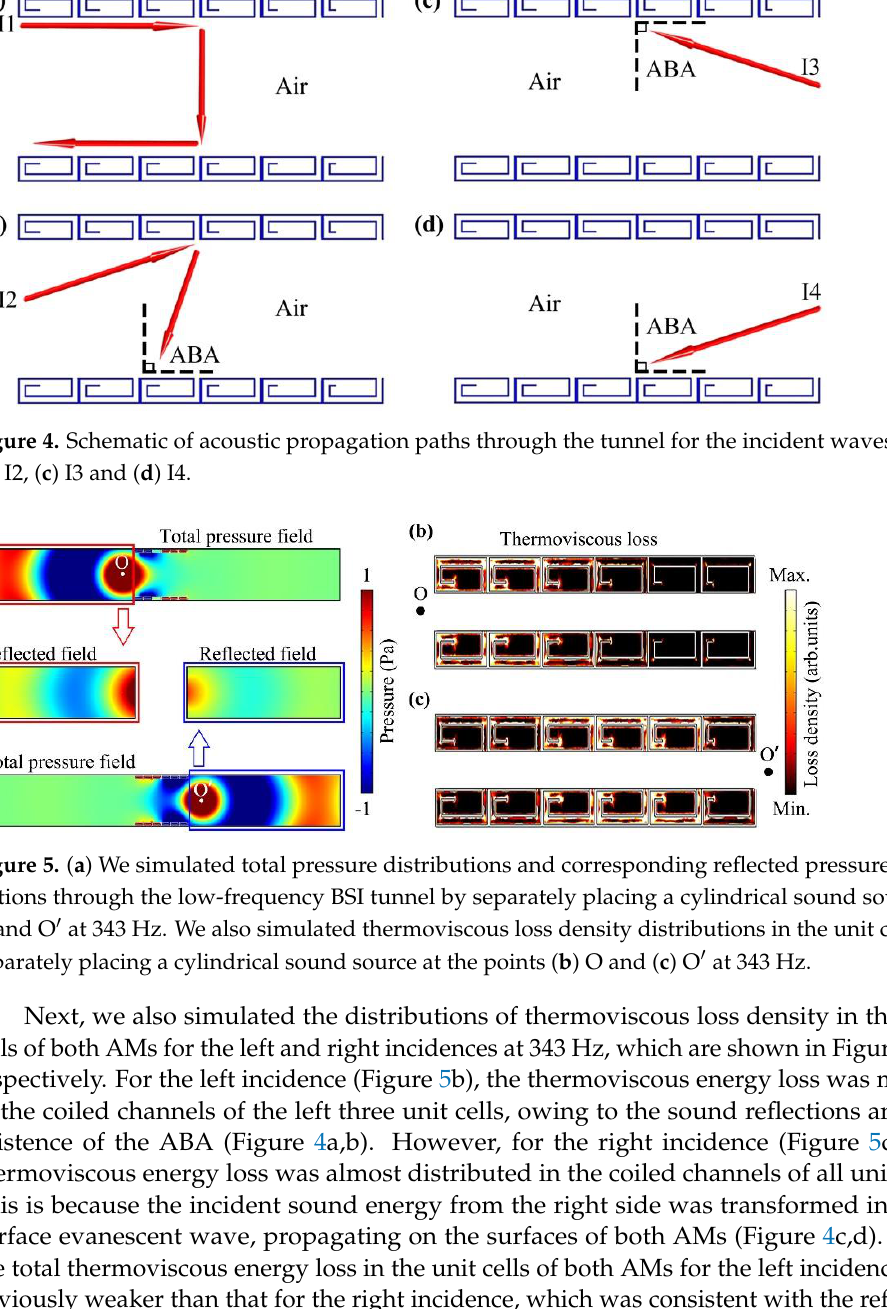
Figure 5. ( a ) We simulated total pressure distributions and corresponding reflected pressure distri- butions through the low-frequency BSI tunnel by separately placing a cylindrical sound source at O and O′ at 343 Hz. We also simulated thermoviscous loss density distributions in the unit cells by separately placing a cylindrical sound source at the points ( b ) O and ( c ) O′ at 343 Hz.